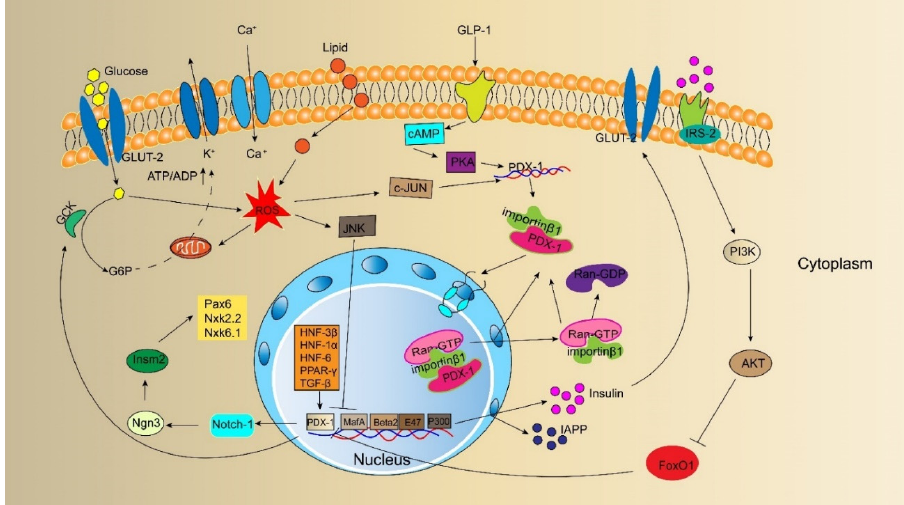
Figure 2. Model outlining upstream regulator and direct downstream target of PDX-1 and the insulin signaling pathway involved by PDX-1 . It has been identified that glucose, lipid, GLP-1, ROS, and other cytokines, such as FoxO1 , HNF-3 β , HNF-6 , PPAR- γ , TGF- β , can directly regulate the expression of PDX-1 . PDX-1 regulates the expression of insulin , GCK , GLUT-2 , IAPP to maintain β -cell characteristics and functions. In addition, PDX-1 involves the signaling pathway of insulin